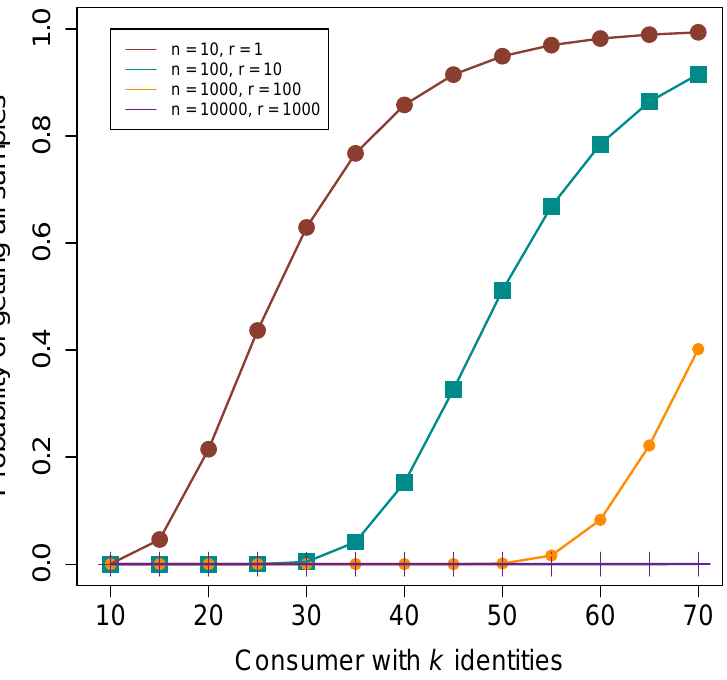
Figure 10. Probability that a consumer with k different identities that gets a 10% of samples with each identity obtains all n different data